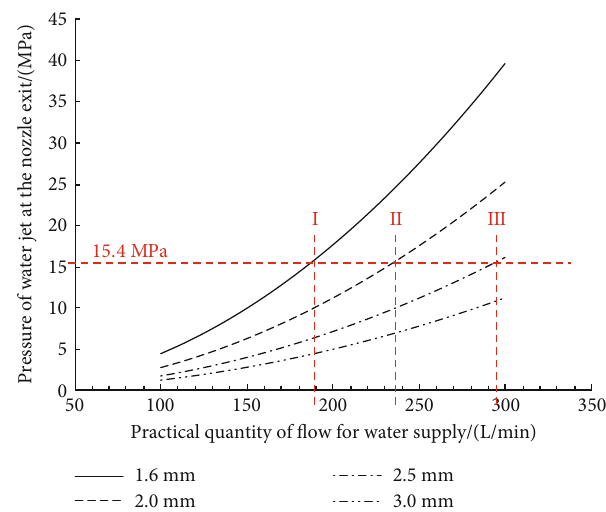
Figure 13: The change law of pressure of water jet at the nozzle